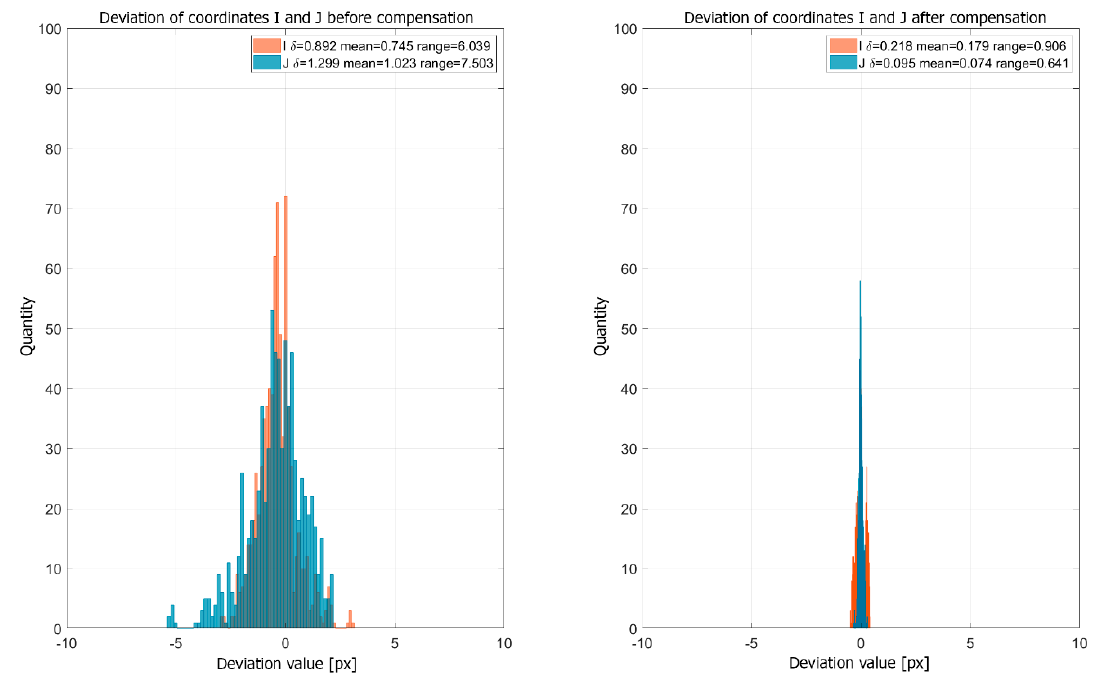
Figure 13. Histogram of deviations of projector marker coordinates before and after the application of the compensation model.